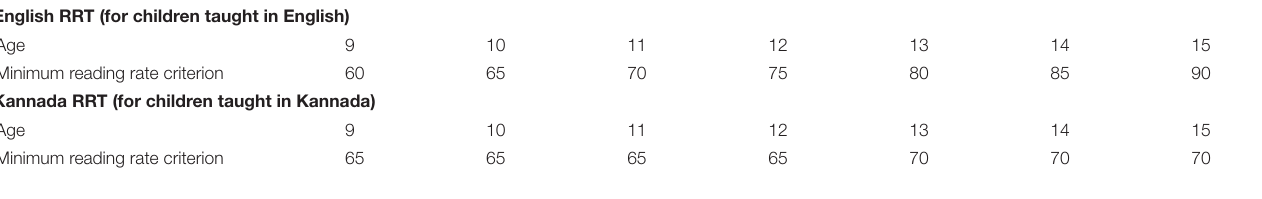
TABLE 3 | Suggested criteria for minimum typical reading rates, by test and